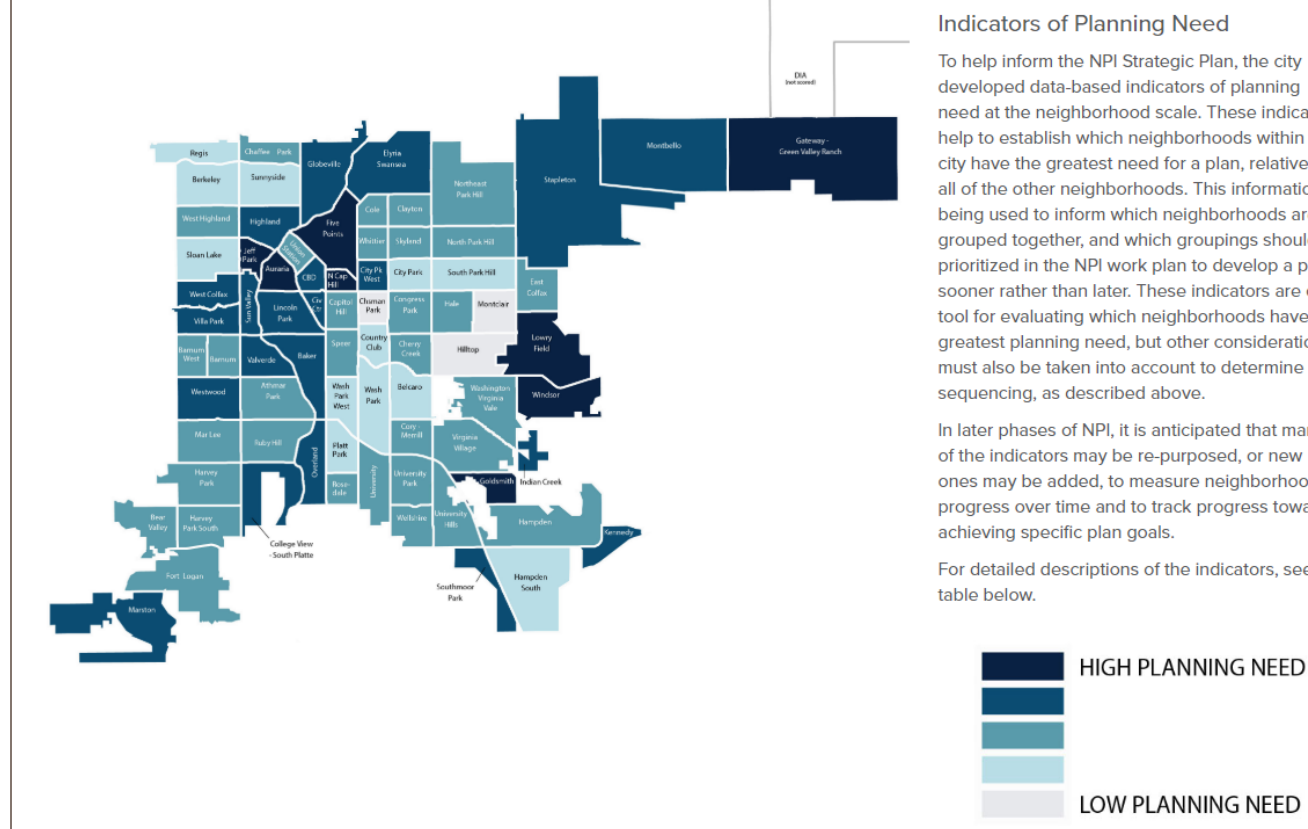
Figure 1: Neighborhood Planning